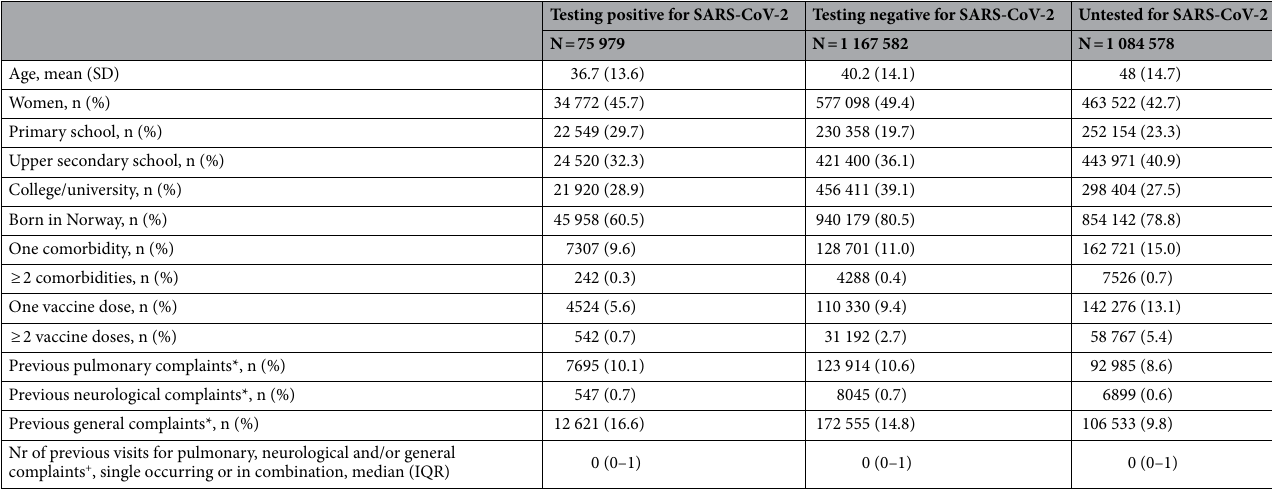
Table 1. Descriptive characteristics. All characteristics measured prior to test. *Visited general practitioner or emergency ward at least once in 2017–19. + General practitioner and/or emergency ward, 2017–19.